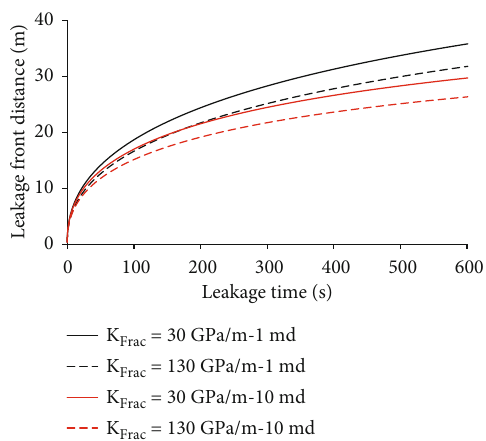
Figure 10: Leakage front distance under di ff erent formation permeability and fracture normal sti ff